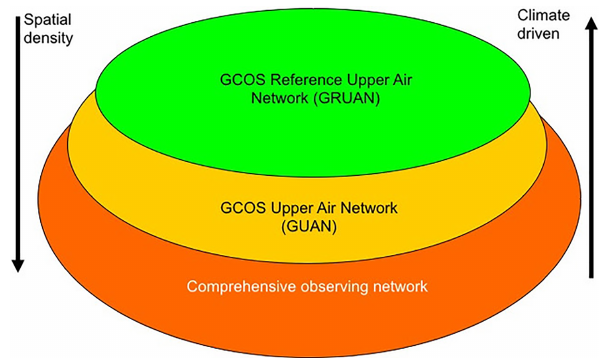
Figure 1. Proposed layers in a system-of-systems approach to be adopted within GAIA–CLIM arising from Seidel et al.